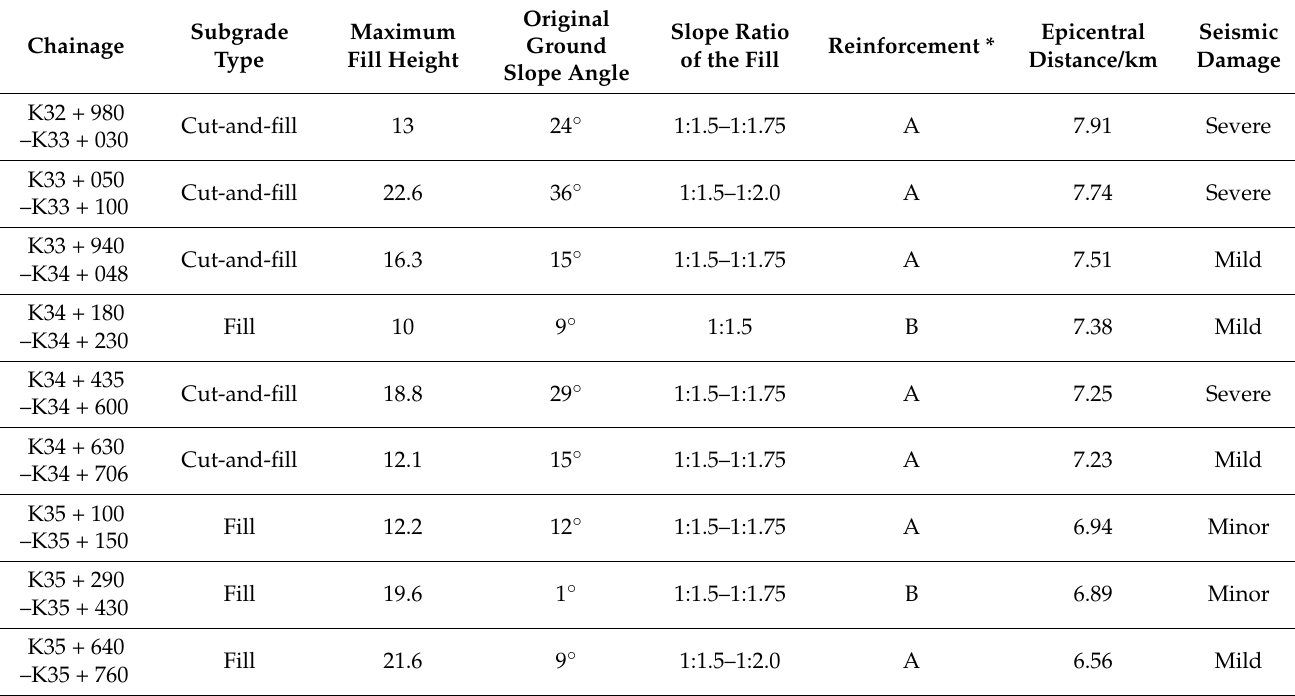
Table 1. Information on the damaged highway subgrades.